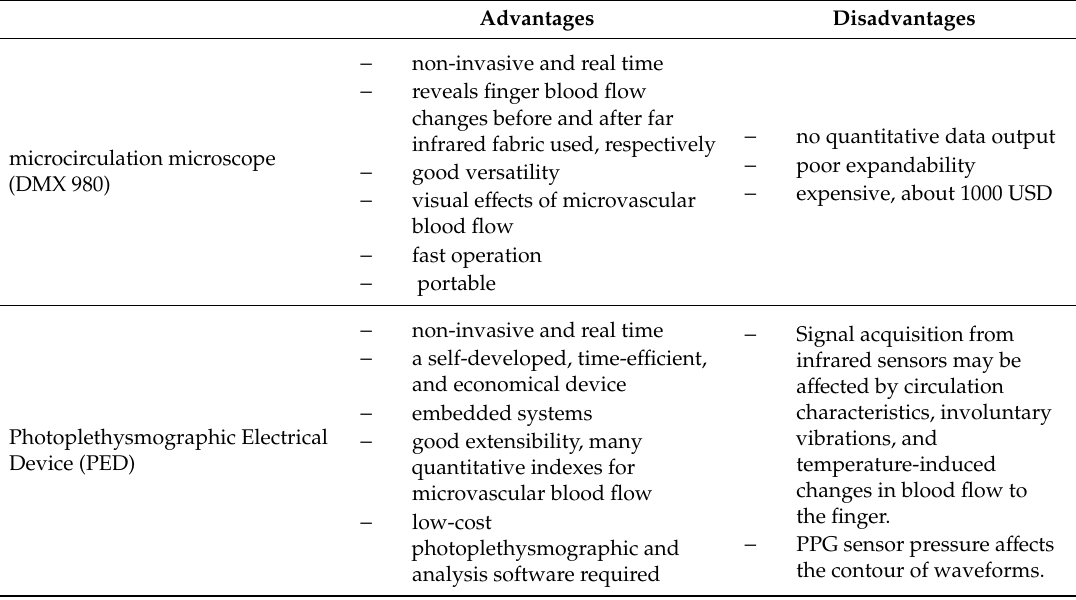
Table 4. Comparisons of advantages and disadvantages of non-invasive far infrared fabric e ff ects verified in previous investigations and the present